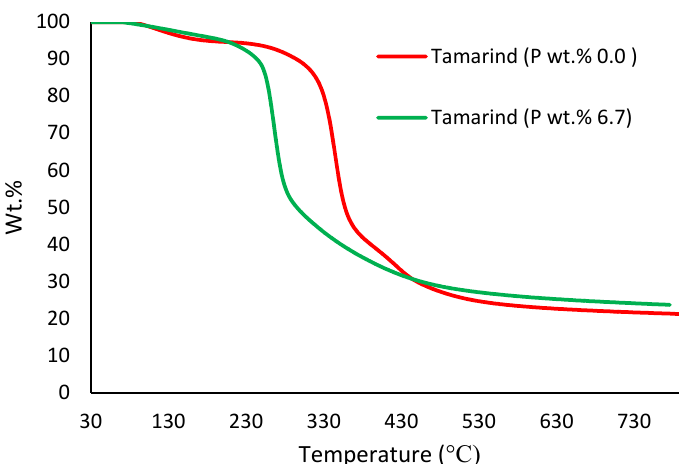
Polymers 2018 , 10 , x FOR PEER REVIEW Figure 6. Thermograms of modified and unmodified versions of tamarind at 60 ◦ C / min. Figure 6. Thermograms of modified and unmodified versions of tamarind at 60 °C/min.